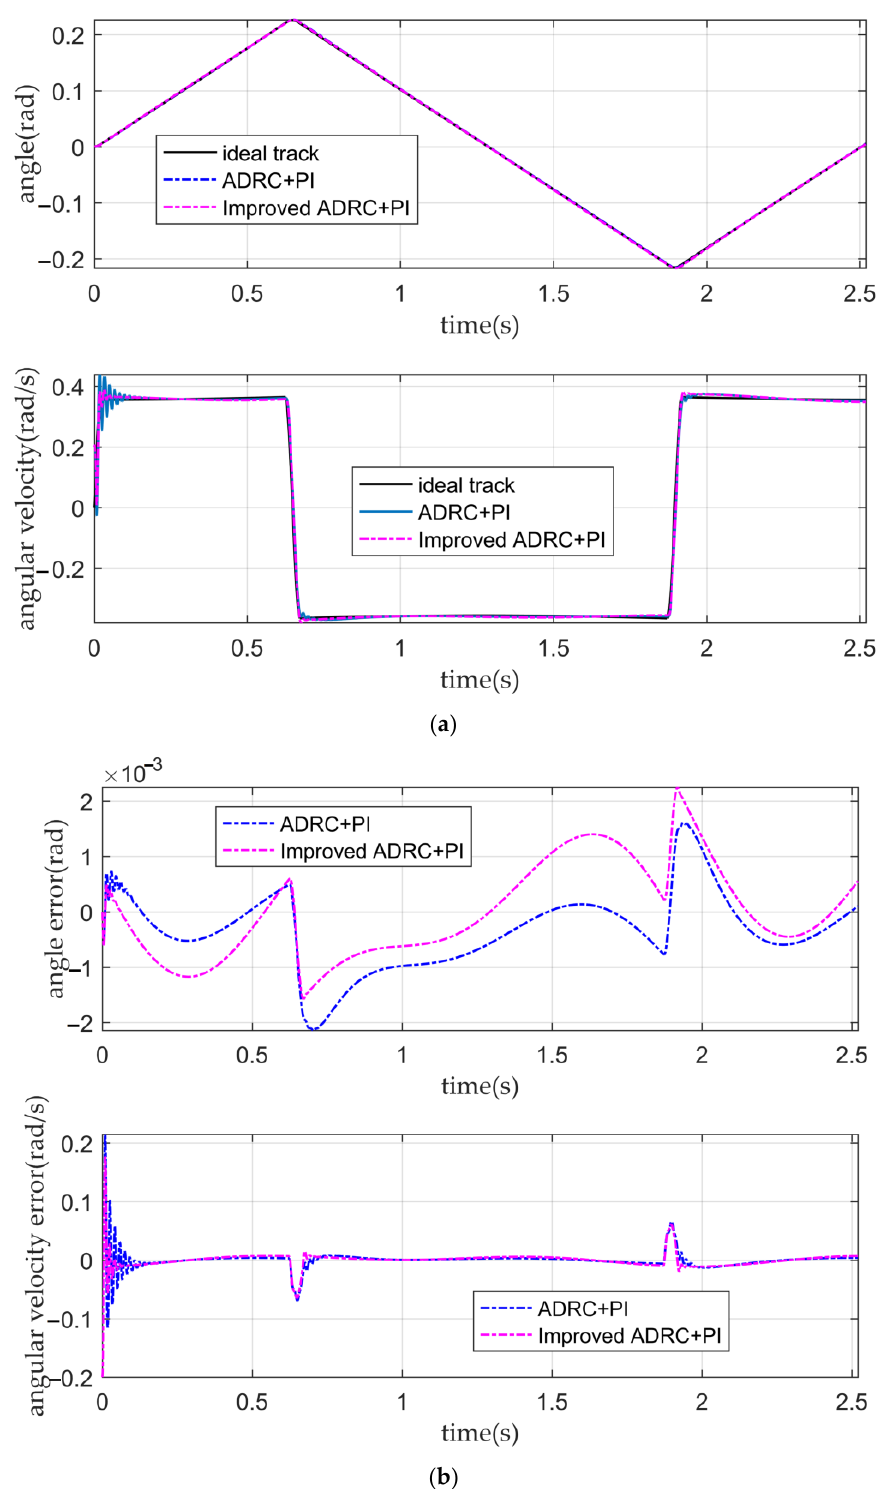
Figure 13. The tracking curves and error curves . ( a ) The angular displacement tracking curves and the angular velocity tracking curves of the conventional active disturbance rejection double closed-loop controller and the IADR-DCLC; ( b ) the angular displacement error curves and the angular velocity error curves of the conventional active disturbance rejection double closed-loop controller and the